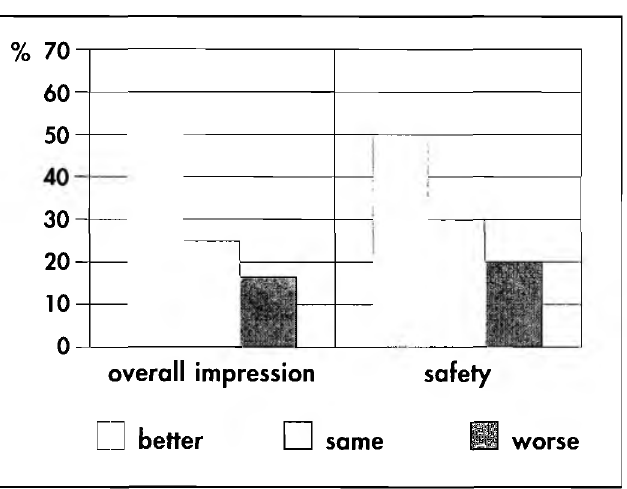
Figure 2: Patients judgement o f the Bally-Valens-Rehab shoes showing a positive overall impression in 58% and in safety in 50% of the patients (n=65, Gamper 1988).